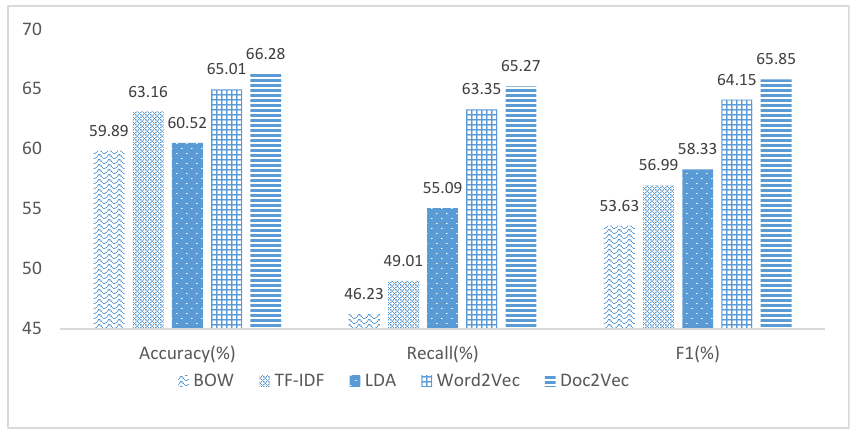
Figure 4. Sentiment analysis results of different